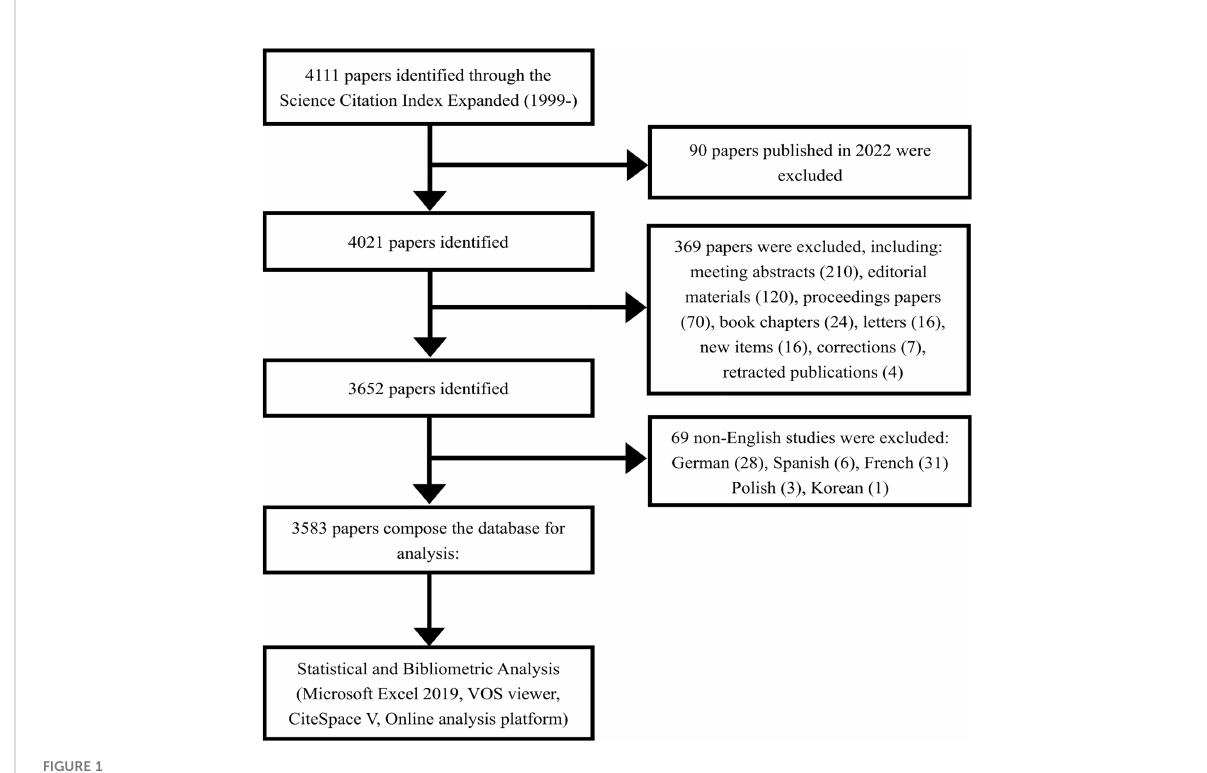
FIGURE 1 Flowchart of the literature screening